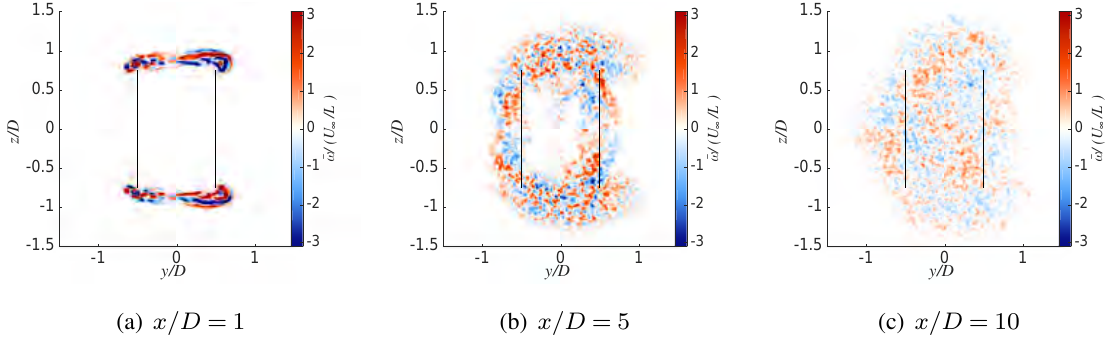
mates these integrals through quadrature over finite